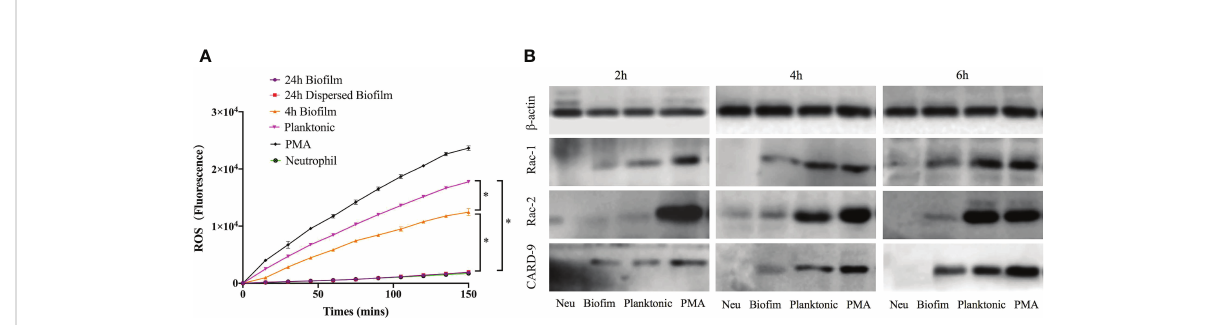
FIGURE 5 ROS-dependent pathway involved in NETs release stimulated by S. mutans . (A) ROS production by neutrophils exposed to S. mutans . Production of ROS in response to S. mutans was measured by fl uorescence after neutrophils were pre-stained with DCFH-DA and co-cultured with different physiological state of bacteria over 150min. ROS production after exposure to 24-h bio fi lm was compared to that of neutrophils control or planktonic cells or 4 h bio fi lm or 24 h dispersed bio fi lm or PMA positive control at each time point using a one-way ANOVA following Bonferroni multiple comparisons post-hoc test with p < 0.05 (n=6), SEM shown. (B) The protein level of Rac-1, Rac-2, and CARD-9 were analyzed using Western Blot. Neutrophils were co-cultured with planktonic and bio fi lm S. mutans for 4h. PMA and neutrophils were served as positive and negative control, respectively. The expression levels of Rac-1, Rac-2, and CARD-9 were determined by Western Blotting. Expression of Rac-1 and Card-9 were signi fi cantly upregulated in a time-dependent manner when exposed to planktonic S. mutans . However, the relative expression of Rac-1, Rac-2, and CARD-9 remained at a low level when challenged with bio fi lm S. mutans . Data were representative of three separate